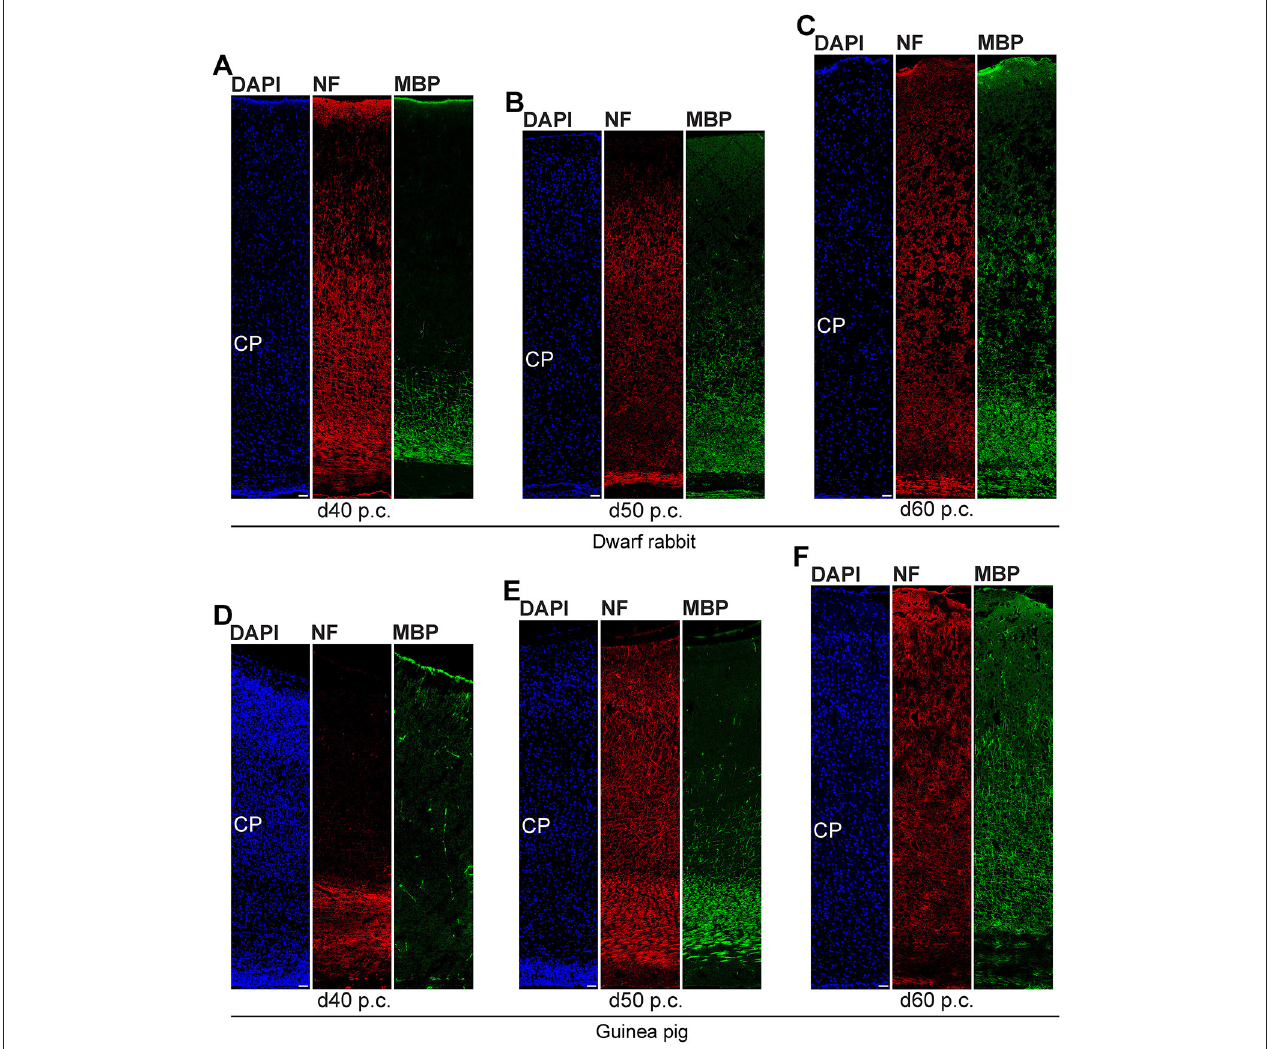
FIGURE 9 | Neurofilament H and MBP expression in the developing dwarf rabbit and guinea pig neocortex. (A–F) Double immunofluorescence for neurofilament H (NF, red) and MBP (green) and DAPI staining (blue) on 30- µ m cryosections of day 40–60 post-conception (p.c.) dwarf rabbit (A–C) and guinea pig (D–F) neocortex. CP, cortical plate. Scale bars, 50 µ